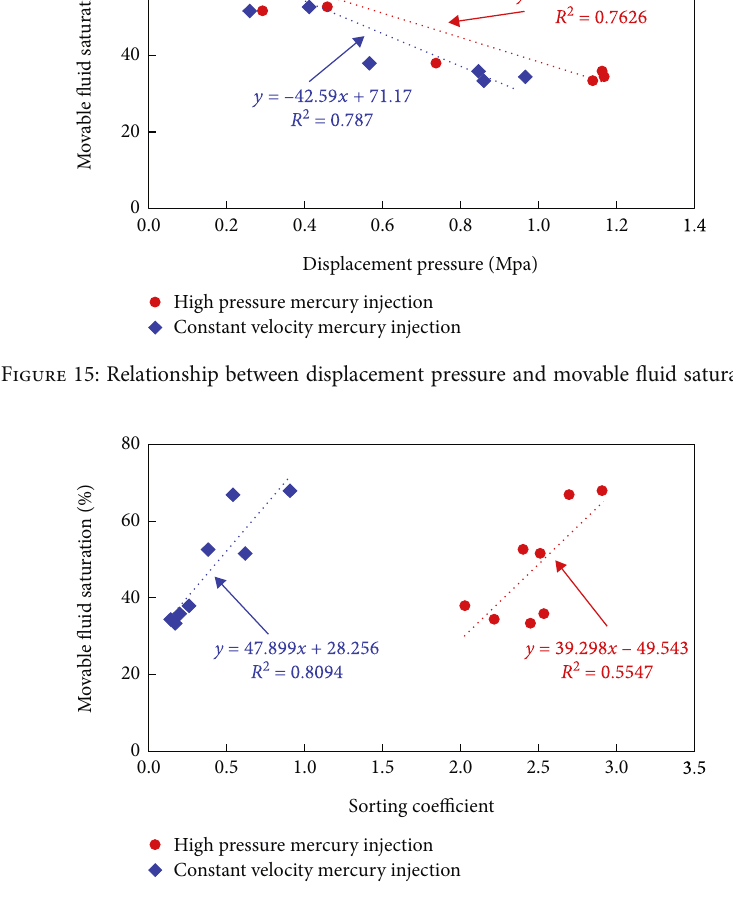
Figure 16: Relationship between sorting coe ffi cient and movable fl uid saturation.